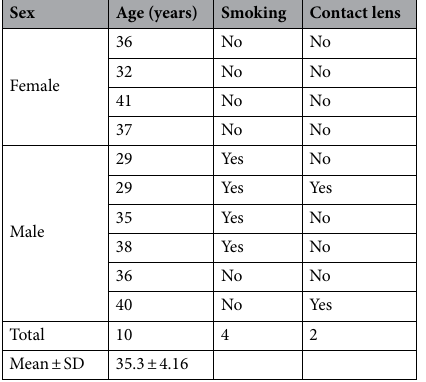
Table 1. Characteristics of the participants in the clinical